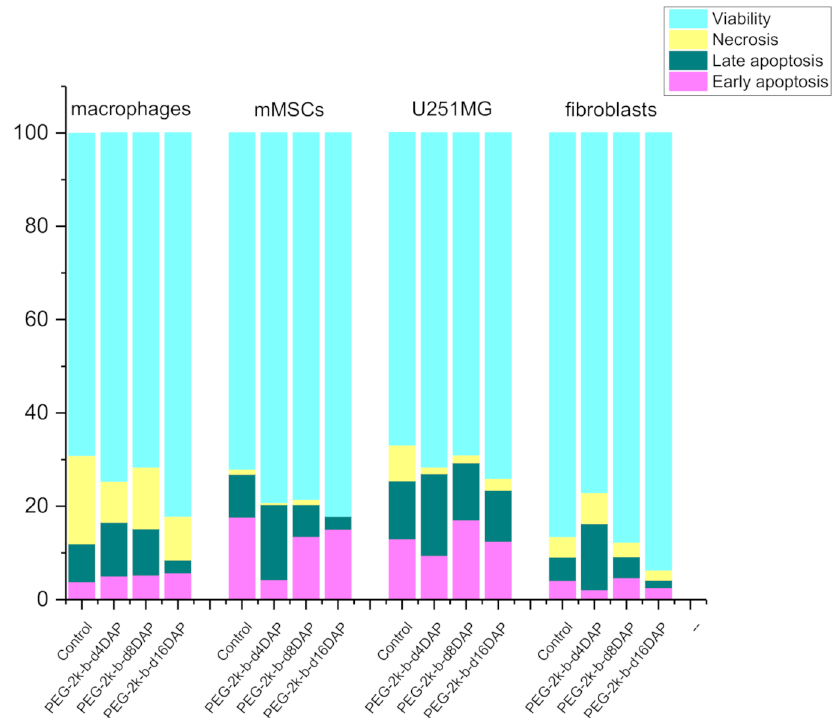
Figure 5. Distribution of early and late apoptotic, alive, and necrotic cells (percentage of cells, %) after treatment for 24 h with PEG 2k - b -dxDAP aggregates obtained by microfluidics (A, Table 3) and with a polymer concentration adjusted at 0.4 mg mL − 1